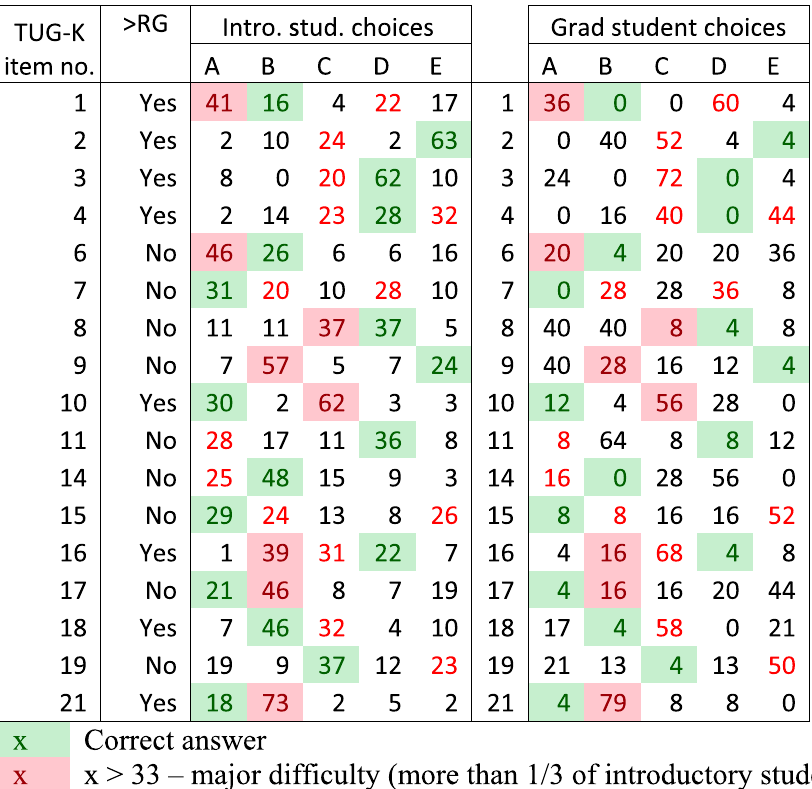
FIG. 1 (color online). Questions on the TUG-K in which at least 20% of introductory students selected an incorrect answer choice in a posttest, percentages of introductory physics students (Intro. stud. choices) who selected each answer choice A through E in a posttest (they were asked to select the correct answer for each question), and graduate students (Grad student choices) who selected each answer choice A through E (they were asked to select the most common incorrect answer for each question if introductory students did not know the correct answer). The first column of the table lists the TUG-K question numbers and the second column (titled > RG ) indicates whether the graduate students on average performed better than random